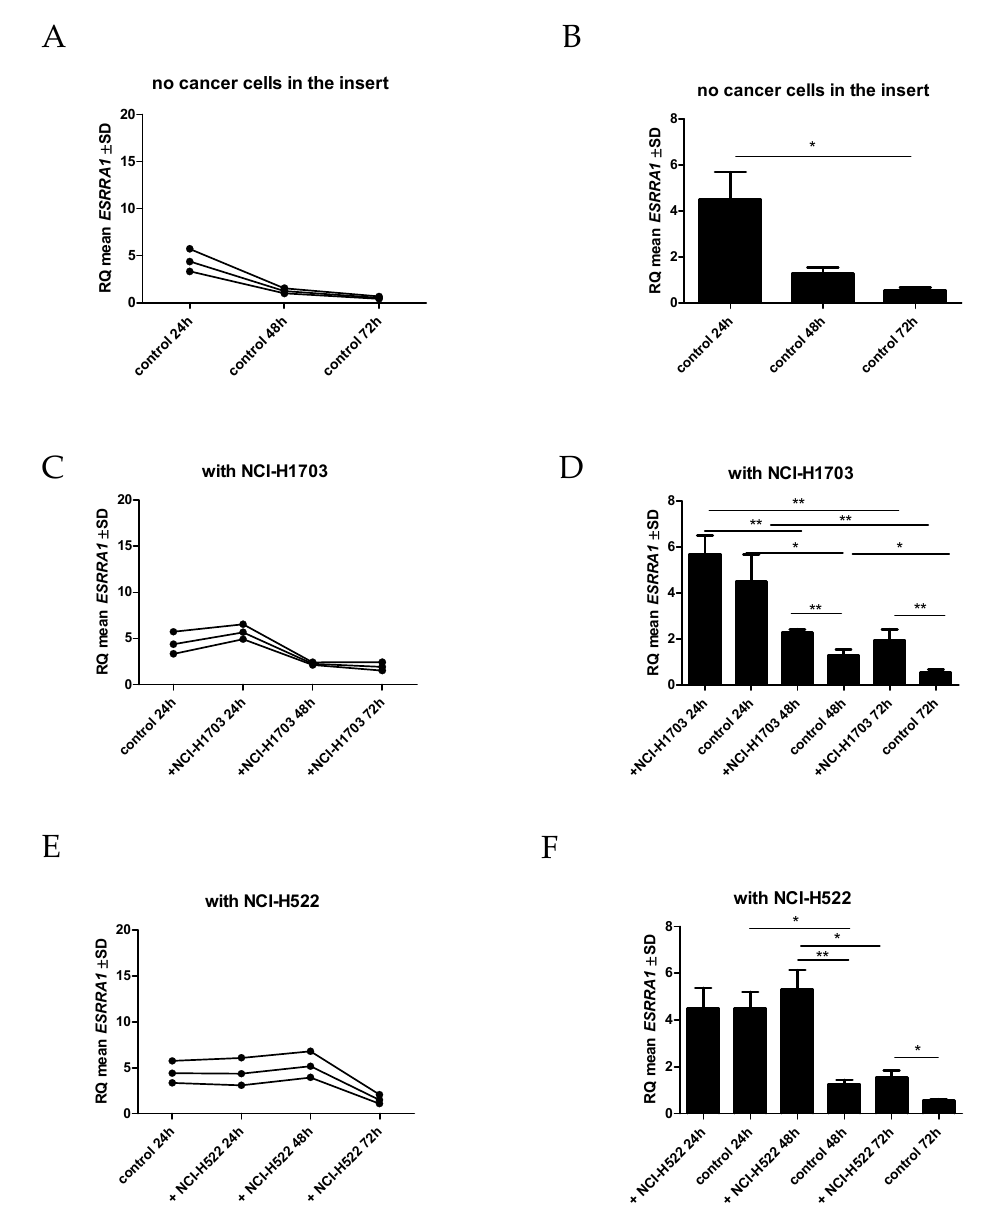
Figure 11. Comparison of the expression level of ESRRA mRNA after co-culture in IMR-90 cells in the empty insert (control) ( A , B ) and the insert with lung cancer cells [NCI-H1703 ( C , D ) and NCI-H522 ( E , F )], * p ≤ 0.05, ** p ≤ 0.005.